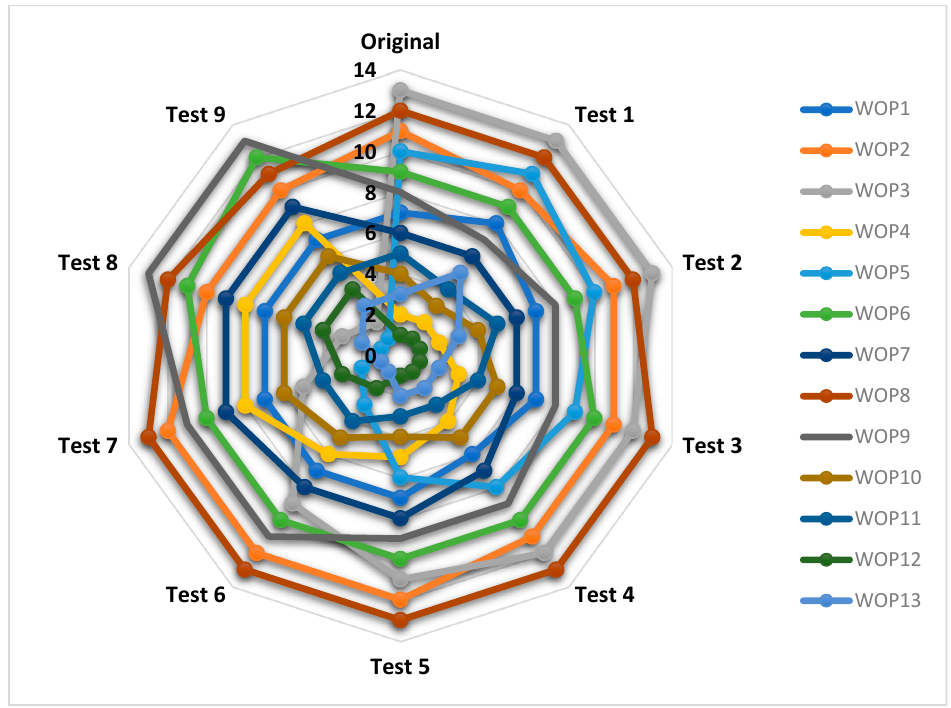
Figure 3. The illustrative ranking of warehouse performances in nine tests.